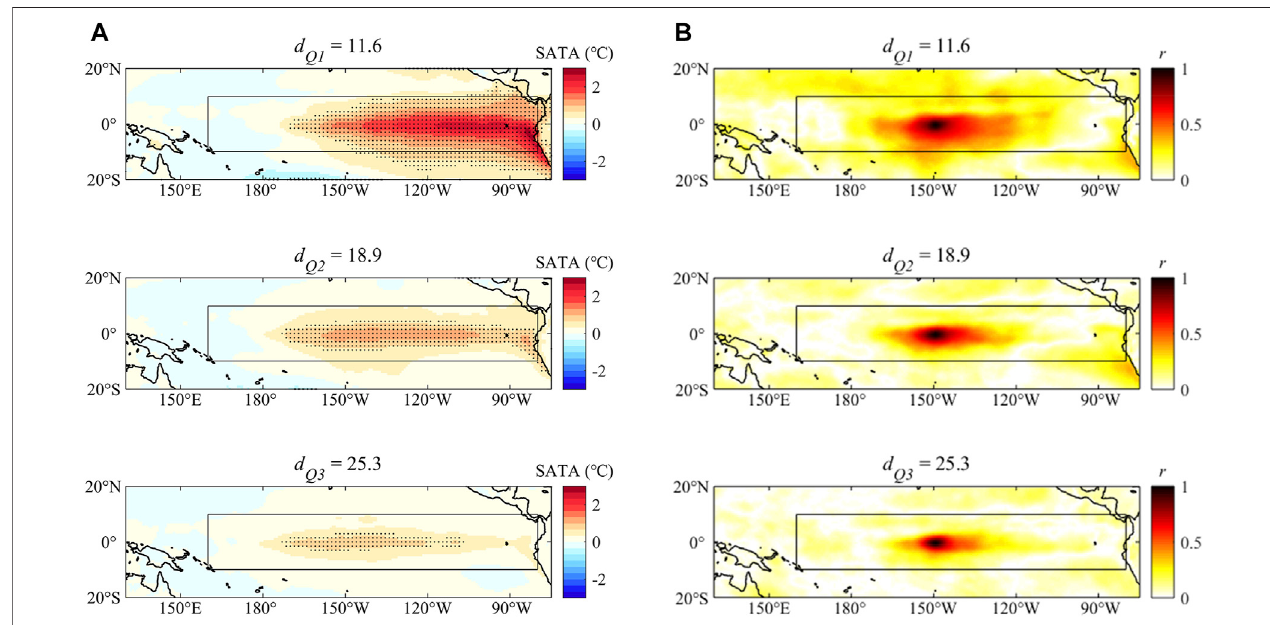
FIGURE 6 | Comparison of the SATA patterns between high and low dimensions (during El Niño episodes). (A) Composite SATA patterns with (top panel) the d Q 1 group (average of d SATA : d Q 1 = 11.6), (middle panel) the d Q 2 group (average of d SATA : d Q 2 = 18.9), and (bottom panel) the d Q 3 group (average of d SATA : d Q 3 = 25.3). (B) Same as (A) , but for the cross-correlation (i.e., r ) of SATAs between each grid and the grid at the central Paci fi c (150 ° W, 0 °